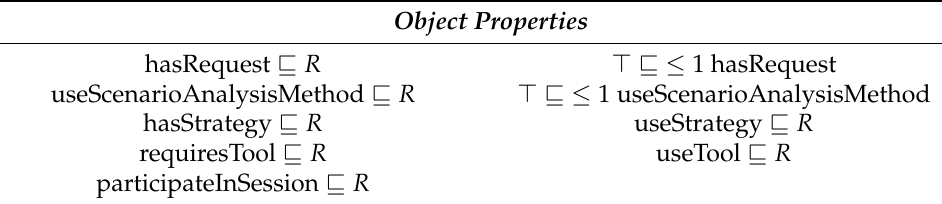
Table 1. AiD-EM Ontology object properties in DL syntax.